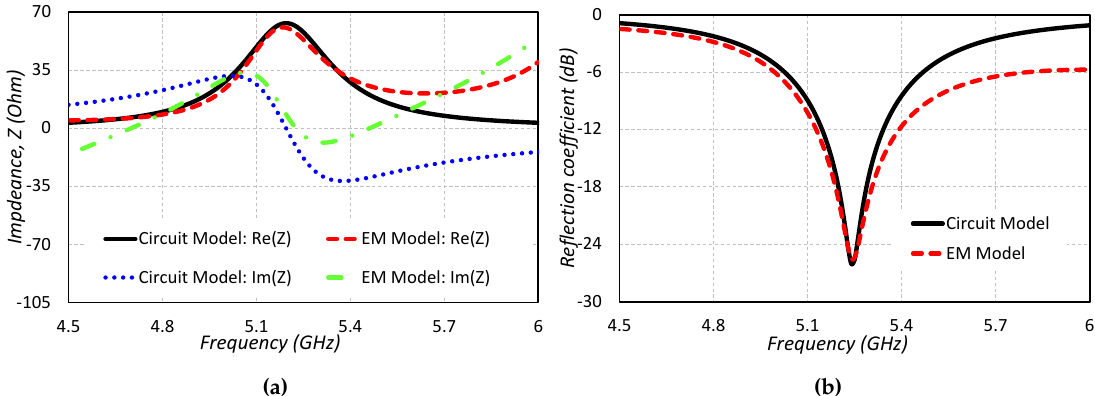
Figure 3. Comparison of the EM model and equivalent circuit model: ( a ) Impedance ( b ) Return loss. Table 1. Equivalent circuit model components values.